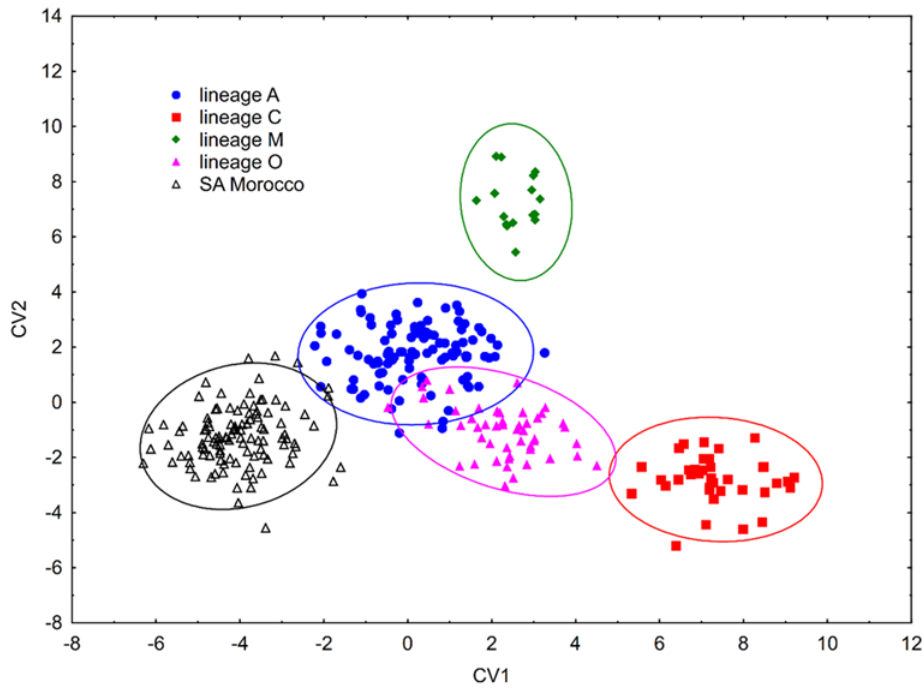
Figure 4. The first two canonical variates illustrating variation of wing shape of honey bees in south- eastern Morocco in comparison to reference samples of four main lineages; A, C, M, O. Each marker represents the mean scores of each colony. The ellipses represent 95% confidence intervals around the centroid of each data cluster.